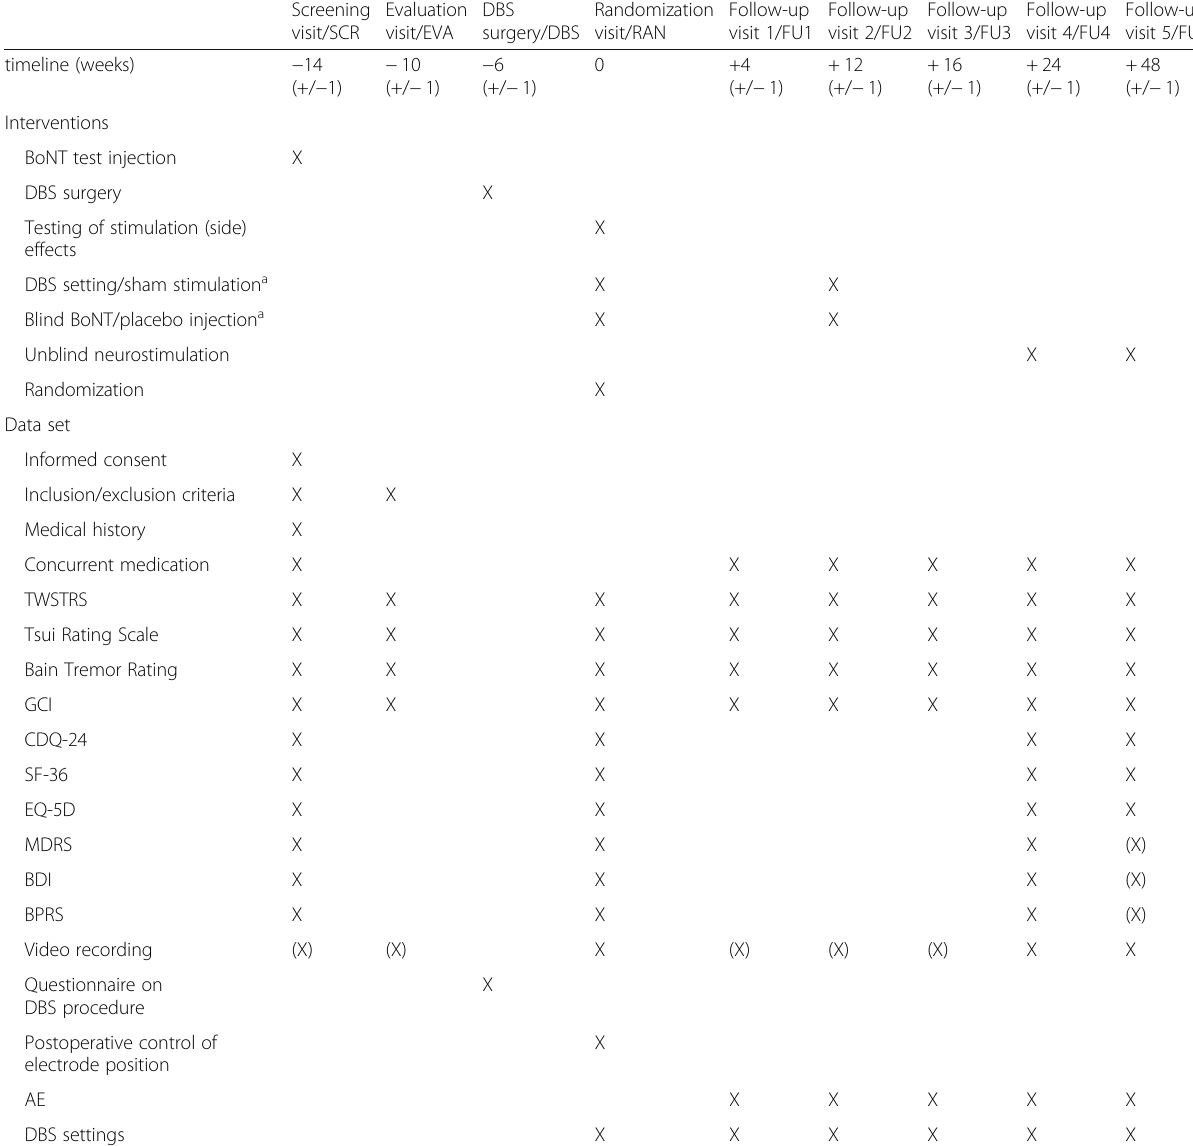
Table 2 Synopsis of interventions and data sets (displayed for single SimTox-CD study visits) Screening